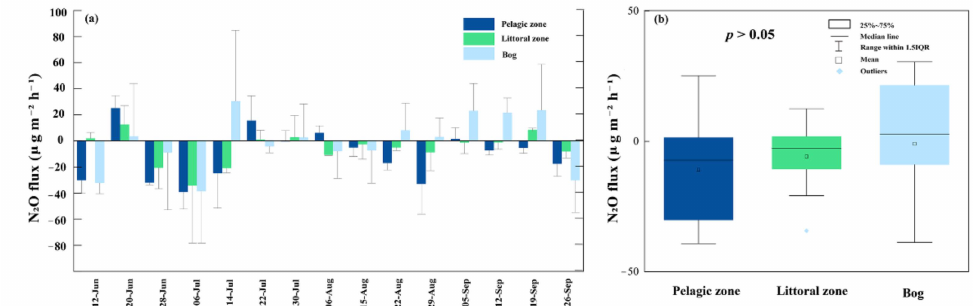
Figure 7. Temporal ( a ) and spatial ( b ) variation in N 2 O fluxes during the growing season. Bars represent mean ± SE. The empty squares, lines within each box, lower and upper edges and bars represent the means, median values, 25th and 75th, 10th, and 90th percentiles,